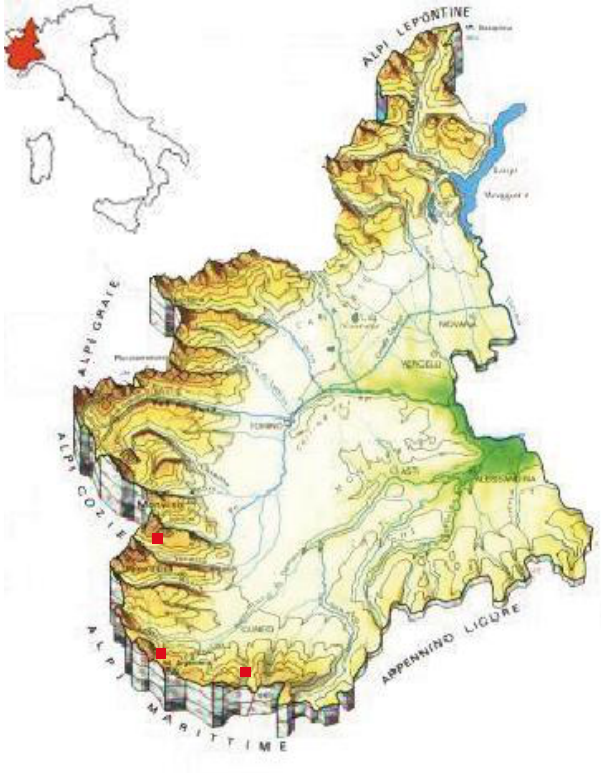
Figure 1. Map of Piedmont. The geographical position of the three stations selected for this study, located in the southwestern sector and highlighted by red